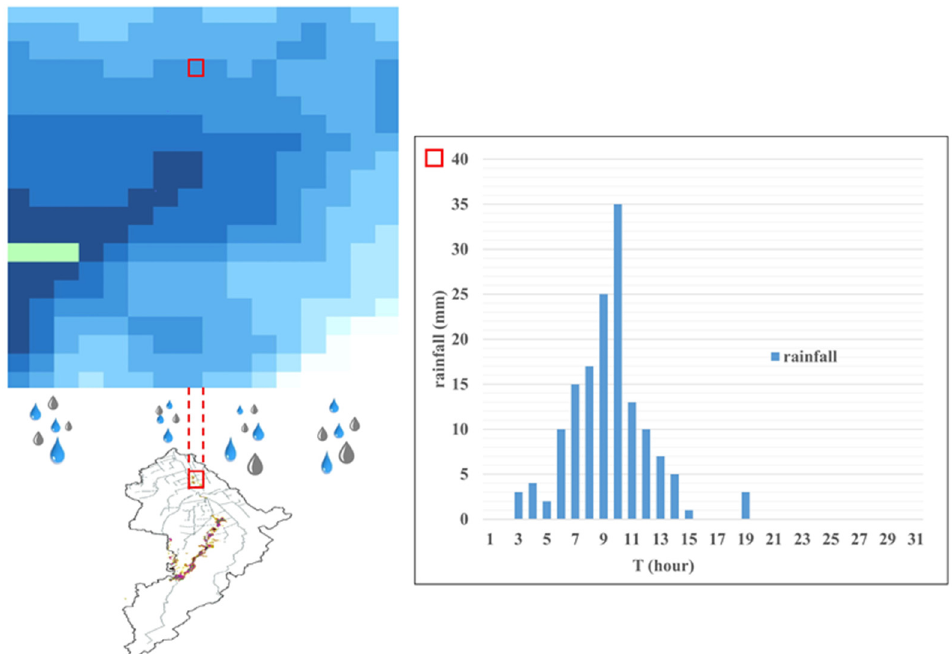
Figure 7. Rainfall map datasets and flooding map datasets developing, analyzing and predicting processes via Artificial Intelligence (AI) platform.